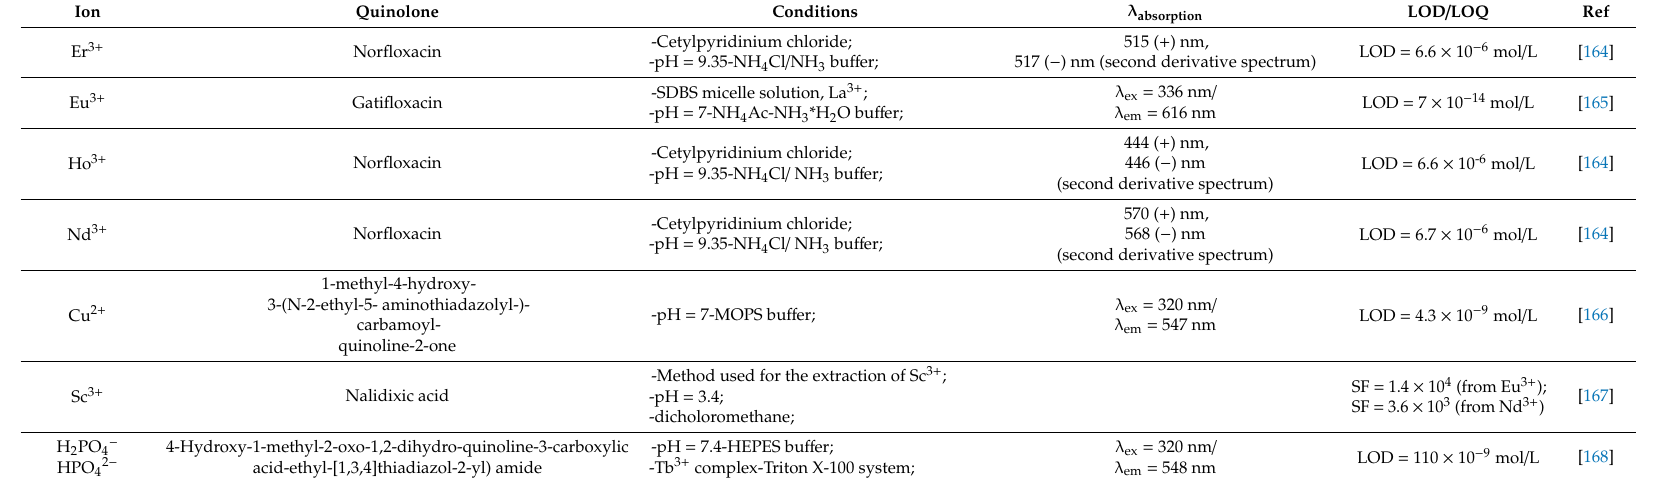
Table 5. Determination of miscellaneous ions using lanthanide–quinolone